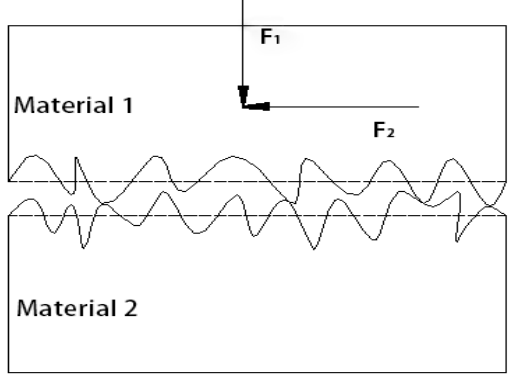
Figure 2. Actual force diagram when the junction surface was connected.